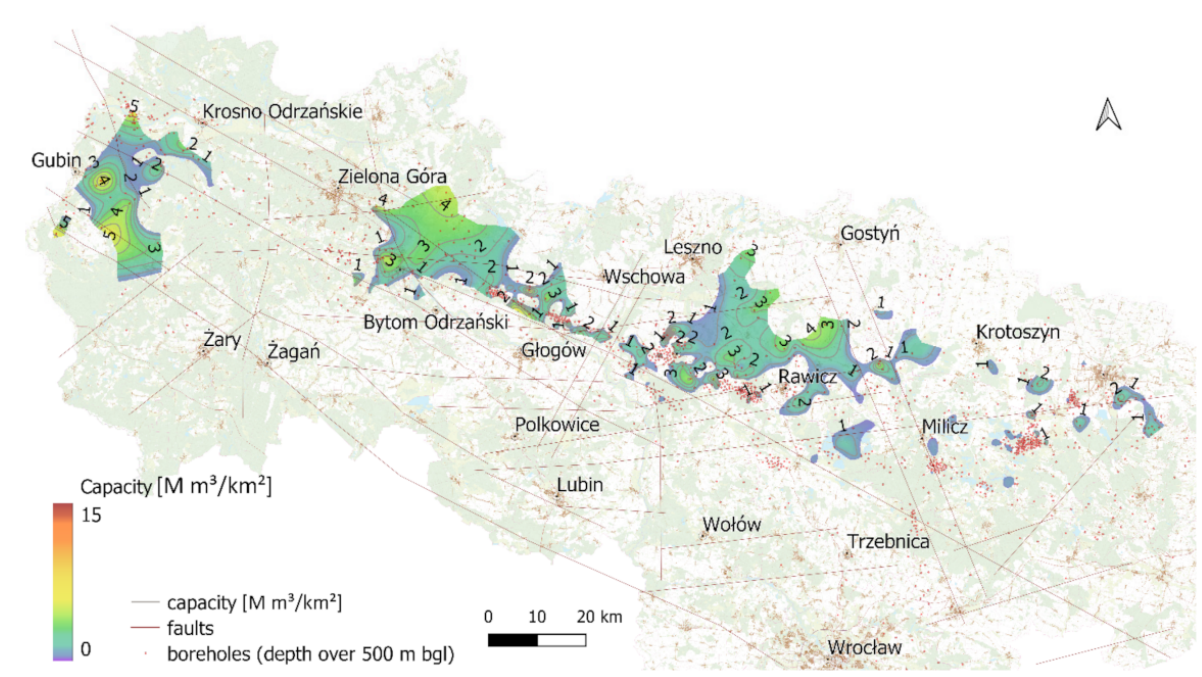
Figure 8. The storage capacity of liquid fuels in the rock salt layer in the Fore-Sudetic Monocline, operational caverns (after the first